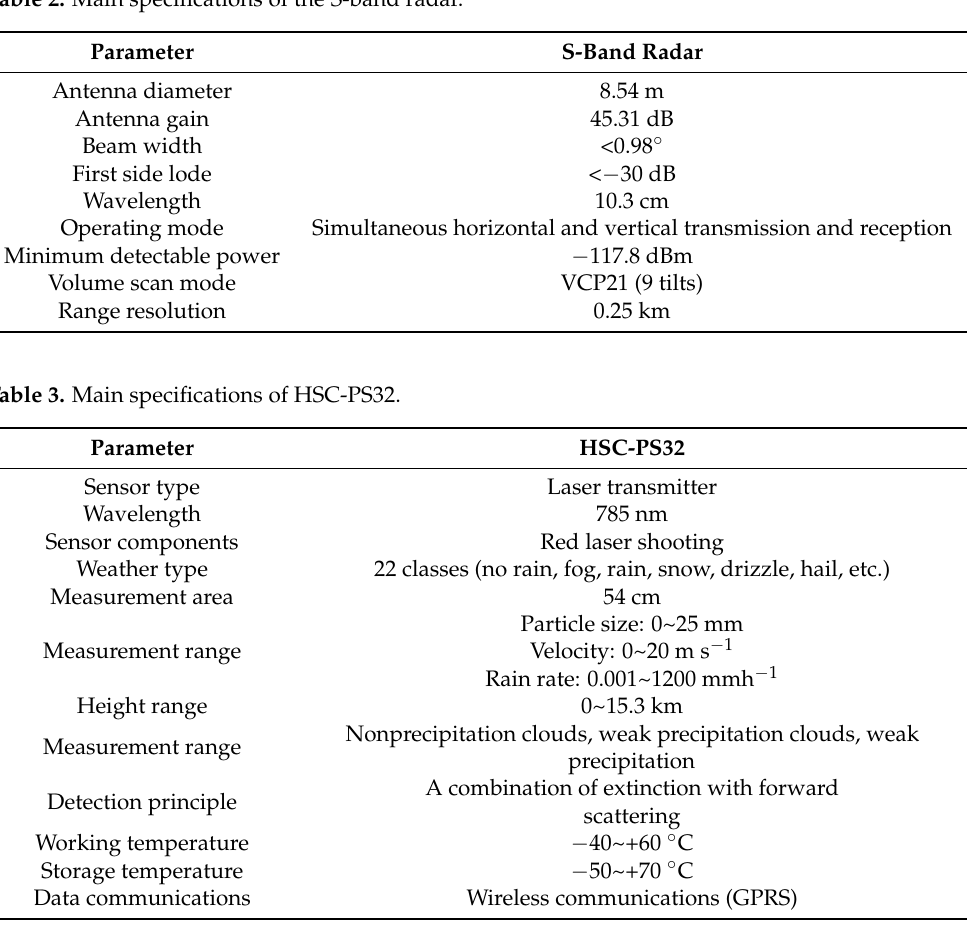
Table 2. Main specifications of the S-band radar.